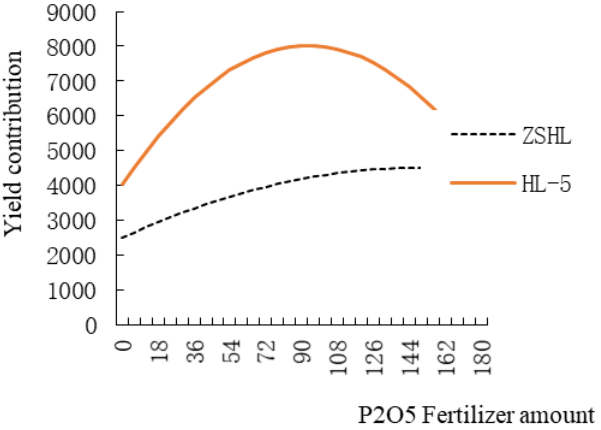
Figure 2. Phosphate fertilizer contribution to broccoli yield.